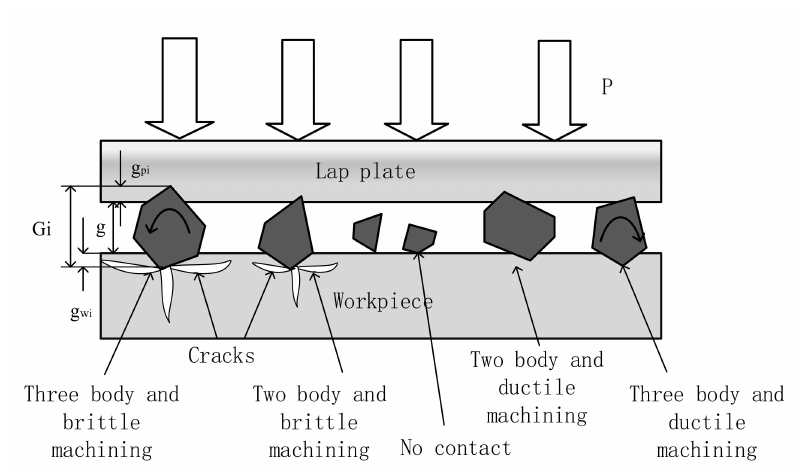
Figure 2. Interaction among abrasive, lapping plate and